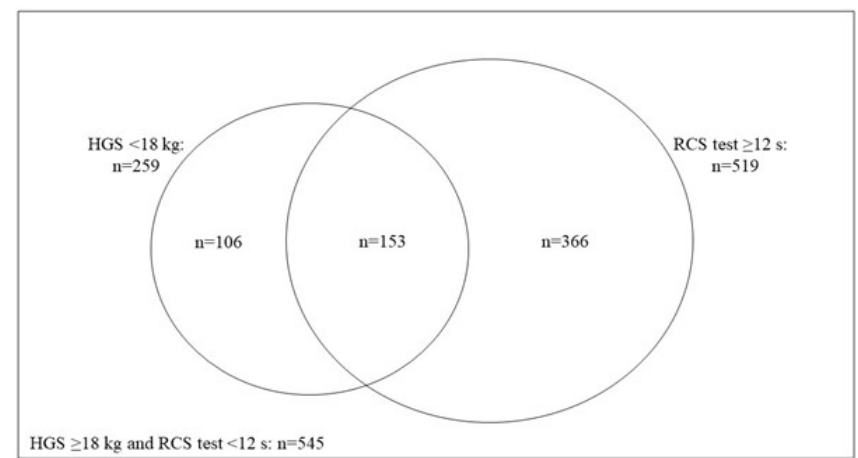
Figure 1. Venn diagram showing the distribution of muscle strength in 1170 subjects. Weak handgrip strength (HGS < 18 kg) only: n = 259 (106 + 153), prolonged 5-repetition chair stand test (RCS ≥ 12 s) only: n = 519 (153 + 366), muscle strength index (MSI): poor MSI (HGS < 18 kg and RCS ≥ 12 s): n = 153, intermediate MSI (HGS < 18 kg only, or RCS ≥ 12 s only): n = 472 (106 + 366), and normal